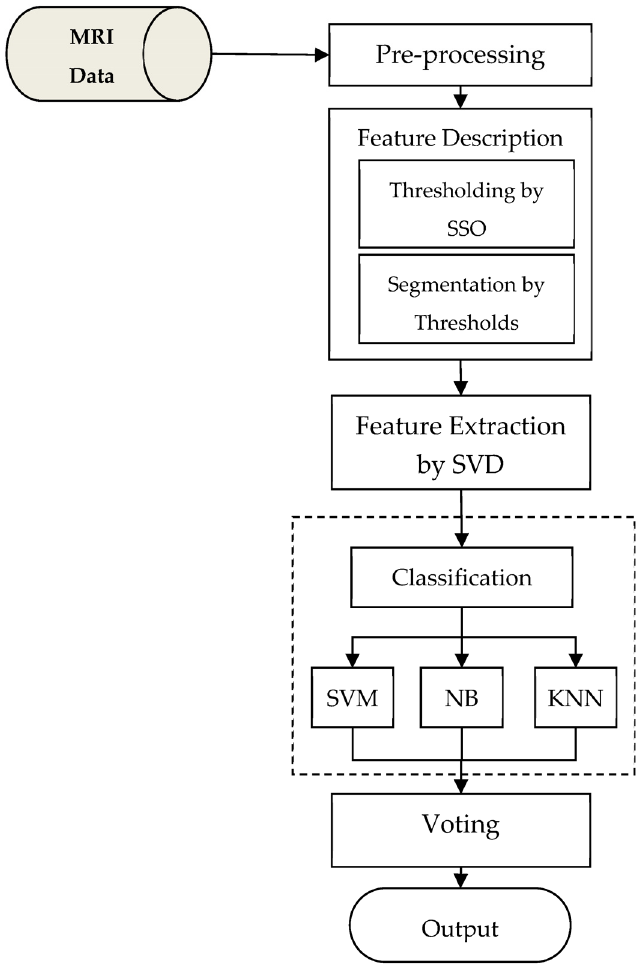
Figure 1. Block diagram of the proposed method